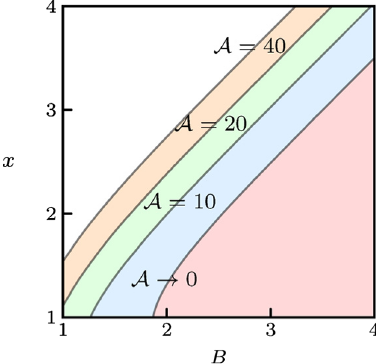
FIG. 5. Product C ϵ 2 for a clock driven by an external protocol. The parameters of the clock are set to χ 1 ¼ χ 2 ¼ 1 , χ 3 ¼ 10 − B , γ ¼ 10 − x , E 0 , E − 1 . 21938 , and E − 1 . 43550 . 1 ¼ 2 ¼ 3 ¼